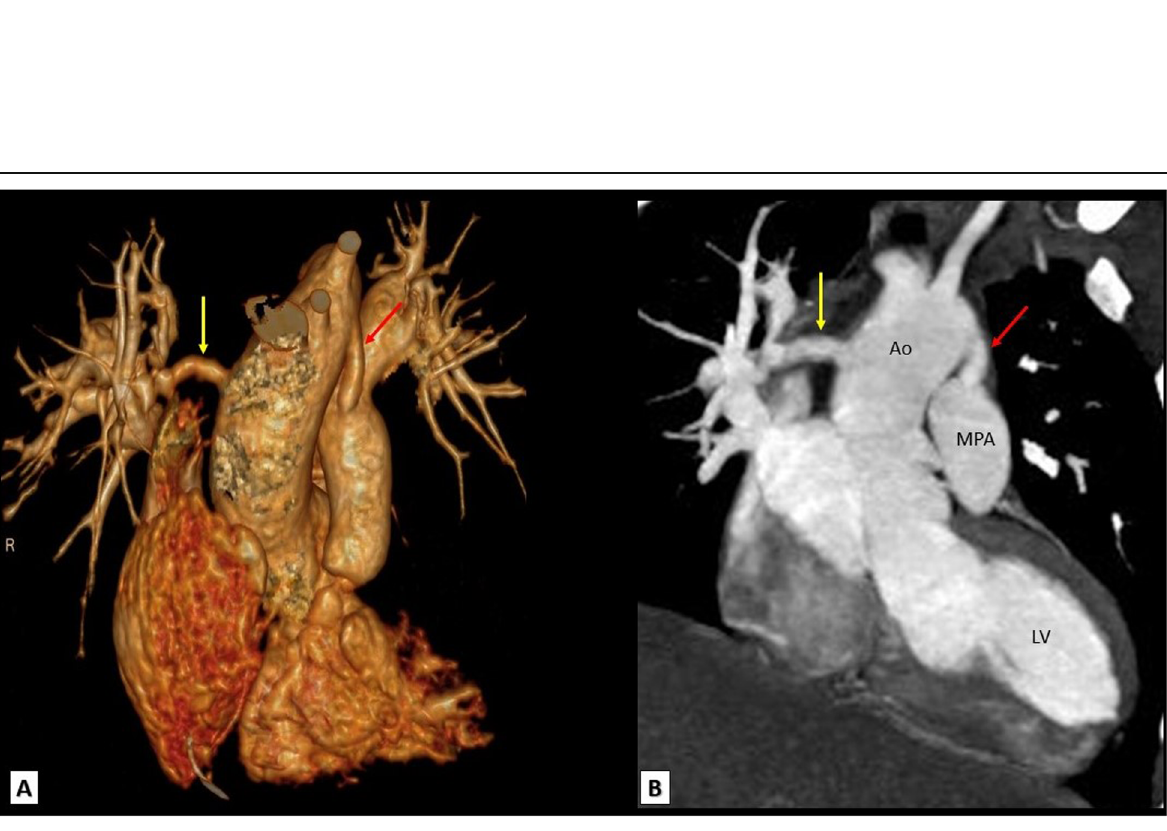
Fig. 9 A TOF patient with bilateral central shunts. a 3D VRT and b reconstructed coronal MDCT images showing a patent central shunt between the aortic arch and main pulmonary artery (red arrows) and another patent central shunt between the ascending aorta and distal right pulmonary artery (yellow arrows). Ao, Aorta; MPA, main pulmonary artery; LV, left ventricle